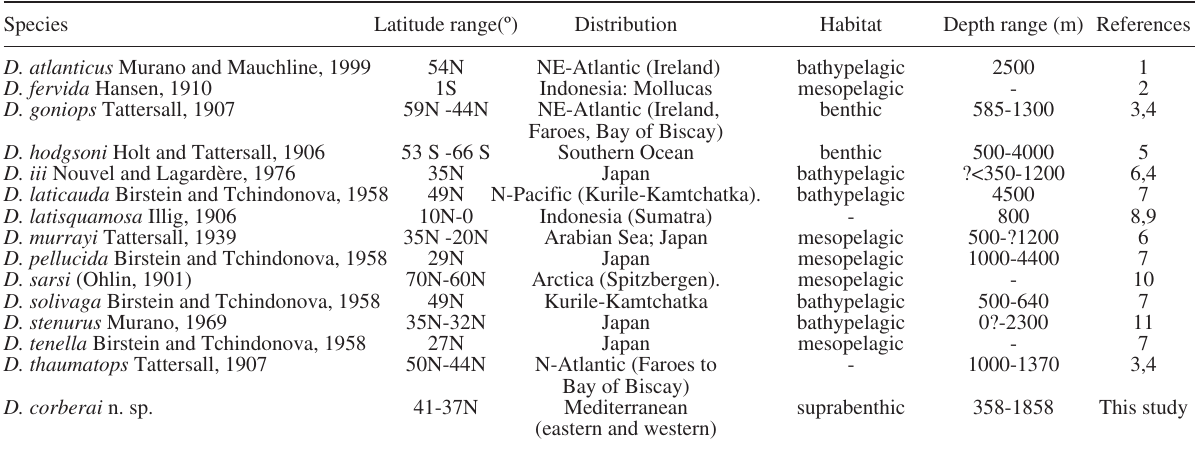
Table 2. – Summary of known data on geographical distribution, bathymetric range and habitat of Dactylamblyops species ( 1 Murano and Mauchline, 1999; 2 Hansen, 1910; 3 Tattersall and Tattersal, 1951; 4 Nouvel and Lagardere 1976; 5 Holt and Tattersall, 1906; 6 Ii, 1964; 7 Birstein and Tchindonova, 1958; 8 Illig, 1906; 9 Illig, 1930; 10 Ohlin, 1901; 11 Murano,